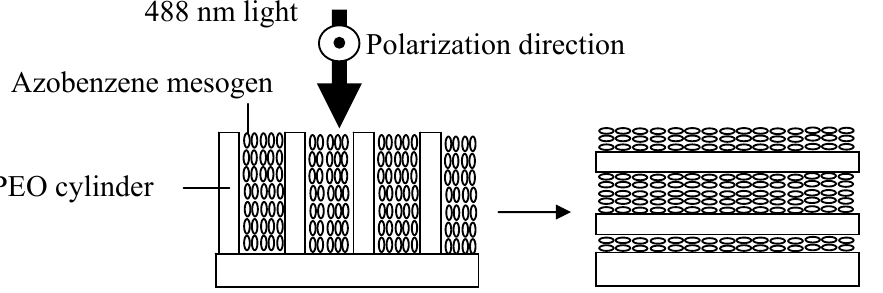
Figure 15. Schematic figure of liquid crystal alignment and microphase-separated